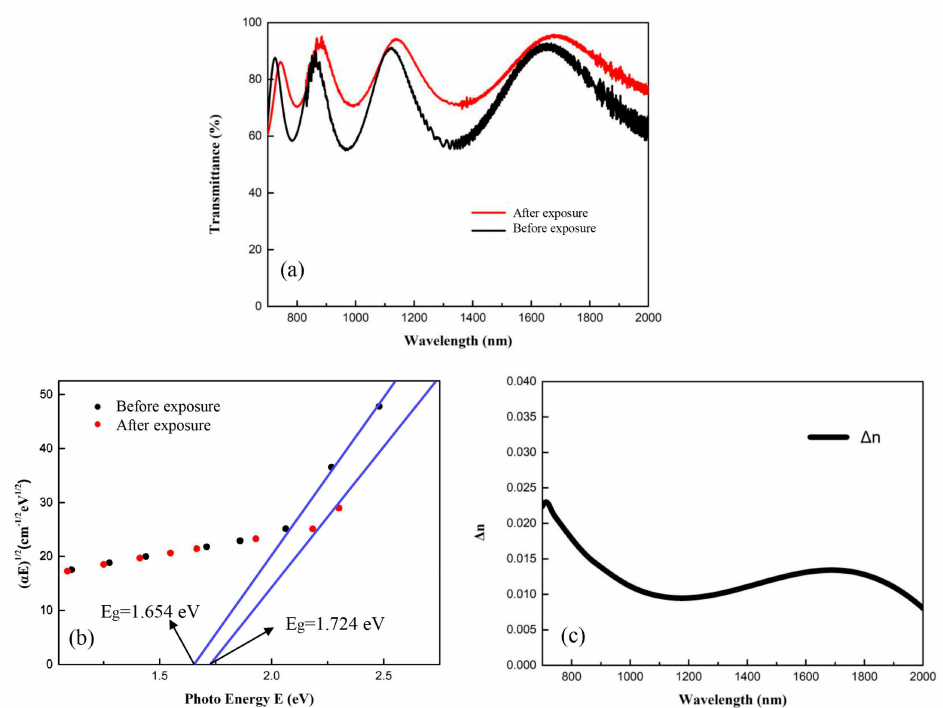
Figure 1. ( a ) Transmission spectra for the as-deposited GSS film and the photobleached GSS film. ( b ) The plot of absorption coefficients versus photon energy. E g is the band gap energy. ( c ) The refractive index changes in GSS film induced by the PB effect.